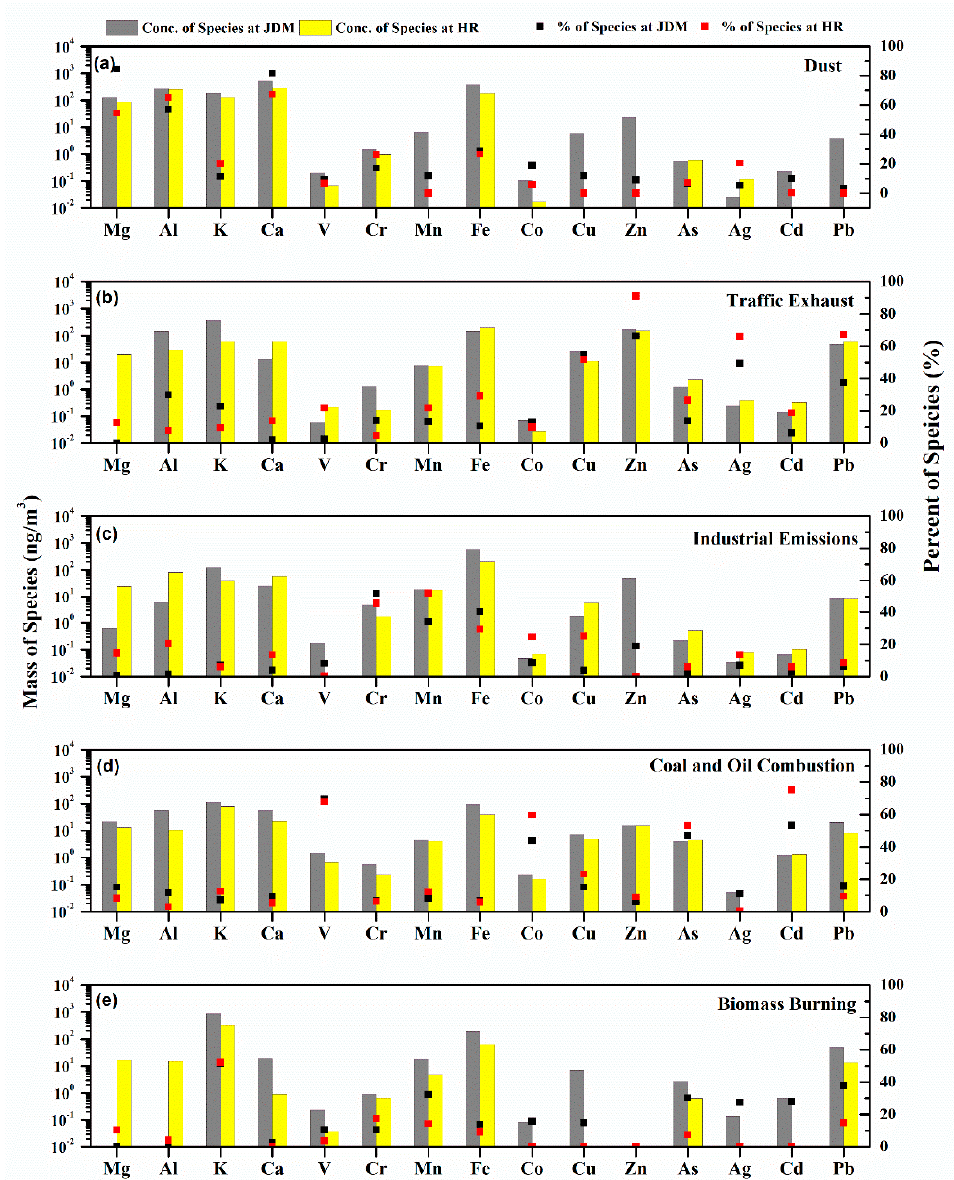
Figure 6. Source profile of the five factors (( a ) dust, ( b ) traffic exhaust, ( c ) industrial sources, ( d ) coal and oil combustion and ( e ) biomass burning) of metallic elements in PM 2.5 resolved by PMF in Beijing urban site (JDM) and suburban site (HR).